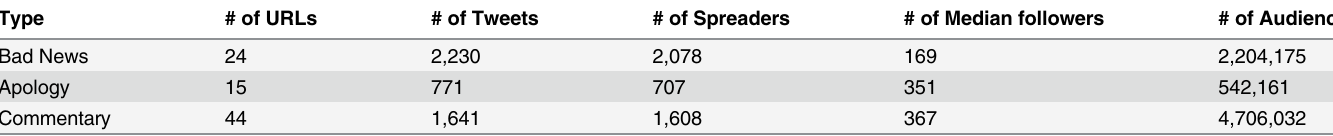
Table 4. Spatial characteristics of the twitter users who spread web links to the bad news, apology video, and commentary, respectively.